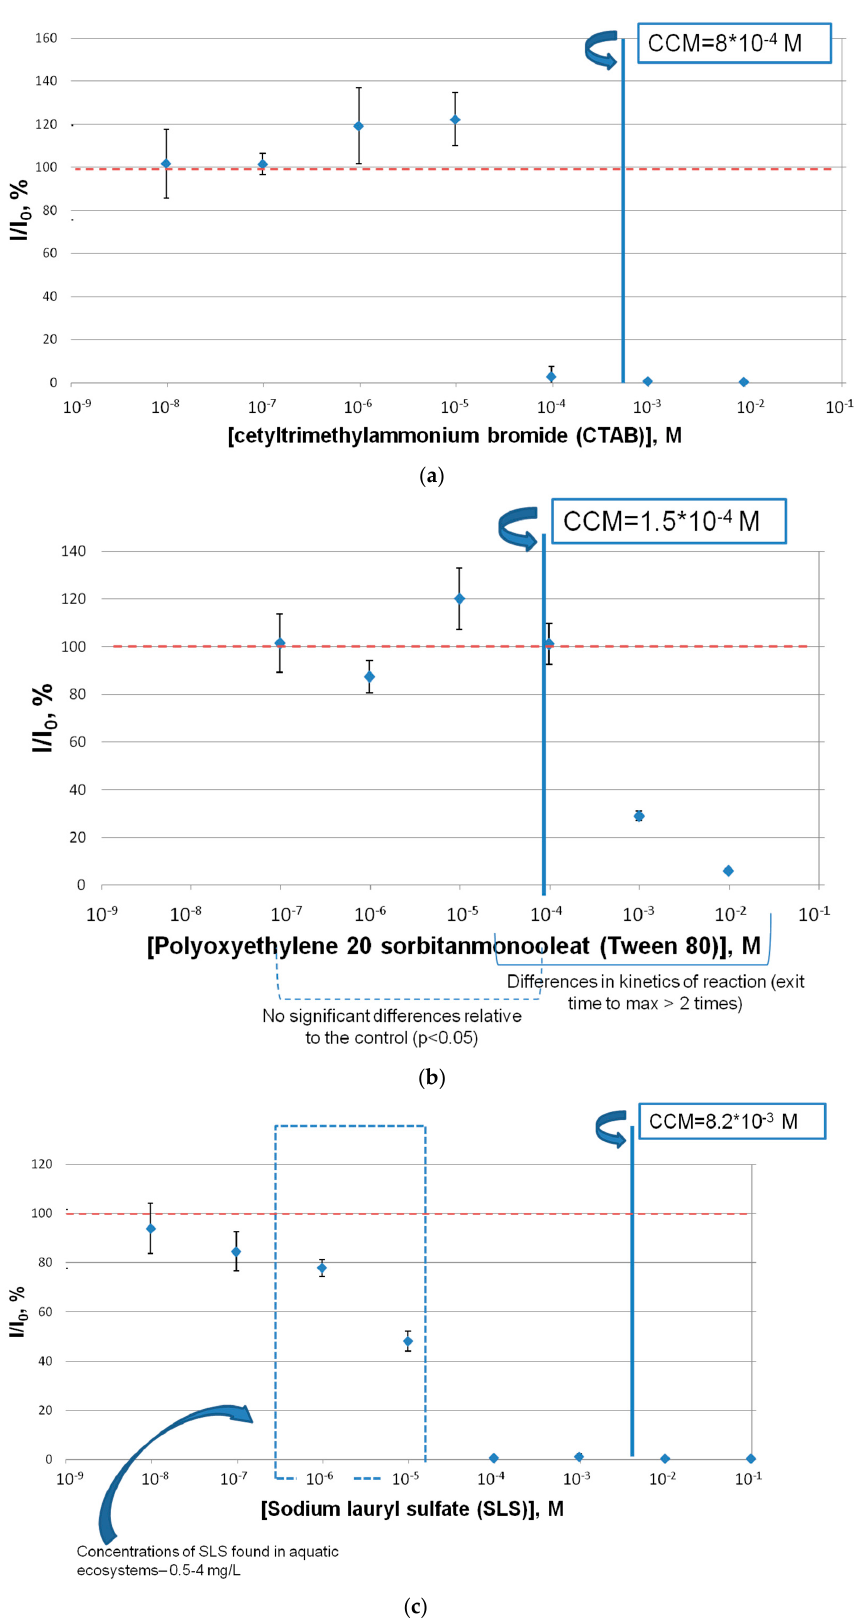
Figure 1. The residual luminescence intensity, I/I 0 , of the coupled-enzyme system Red + Luc in the presence of Tween 80 ( a ), CTAB ( b ) and SLS ( c ). The red dotted line means the activity of the Red + Luc enzyme system in the absence of the surfactants. The half-maximum inhibitory concentrations (IC 50 ) for SLS were calculated (Table 1). Table 1. The values of the parameters IC 50 and EC 50 for the Red + Luc enzyme system and lumi- nous bacteria. The data are presented as the molar concentration (M). nd—not determined, low inhibition (%) at the maximum concentration tested.